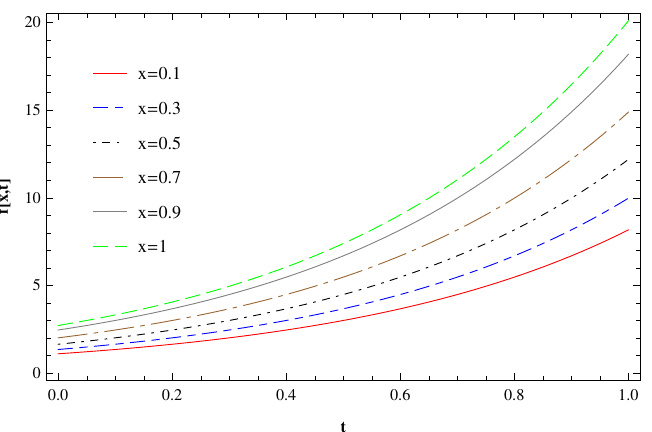
Figure 3. The FRDTM solutions f ( x , t ) for (exact (nonfractional)), β = 0.8,0.6,0.4; x ∈ [ 0,1 ] and t = 0.1.